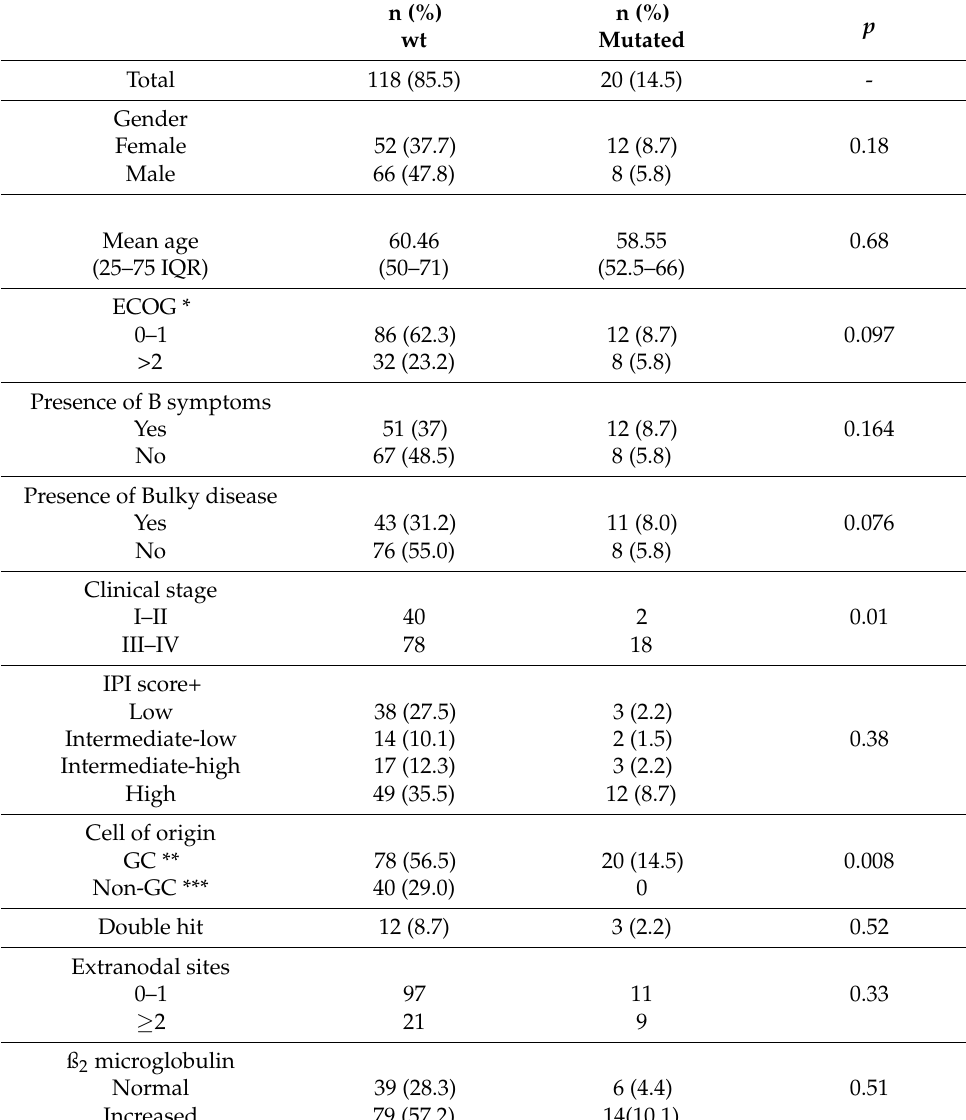
Table 1. Clinical and histological characteristics at